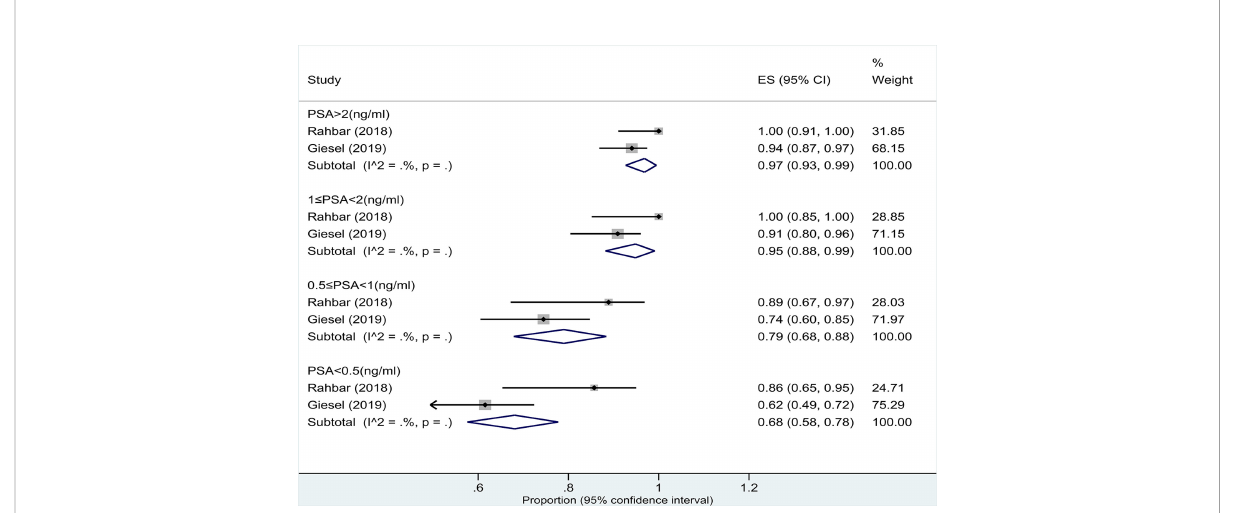
FIGURE 5 Plot of the pooled detection rate of 18 F-PSMA-1007 PET/CT for prostate cancer with biochemical recurrence based on patient analysis with PSA levels >2.0, 1.1 – 2.0, 0.51 – 1.0, and ≤ 0.5